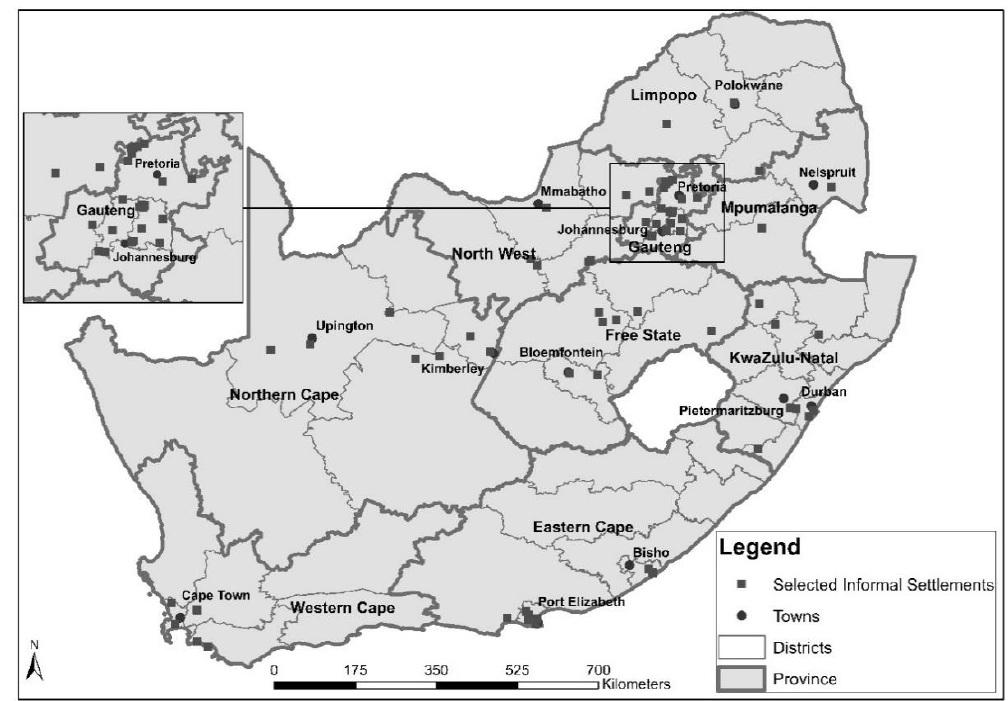
Figure 1. Selected/visited informal settlements in South Africa. Figure 1. Selected / visited informal settlements in South